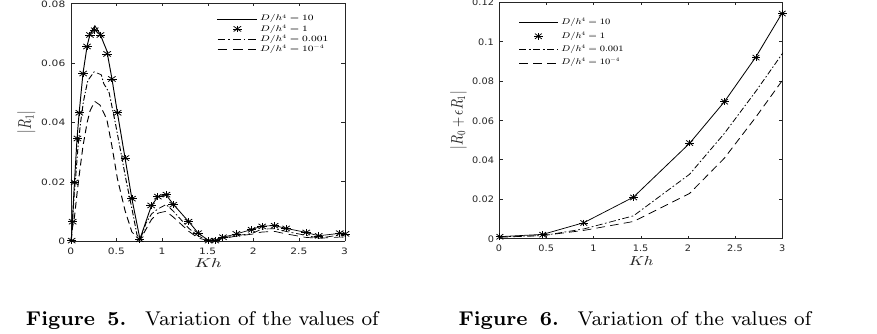
Figure 5. Variation of the values of Figure 6. Variation of the values of | R 1 | with respect to Kh for different | R 0 + (cid:15)R 1 | with respect to Kh for values of D/h 4 when l 1 /h = 0 . 1 ,l 2 /h = different values of D/h 4 when l 1 /h = 0 . 2 ,M = 1 ,c 0 /h = 0 . 1 ,λh = 1 and 0 . 1 ,l 2 /h = 0 . 2 ,M = 1 ,c 0 /h = 0 . 1 ,λh = 1 m/h = 0 . 001. and m/h = 0 . 001.